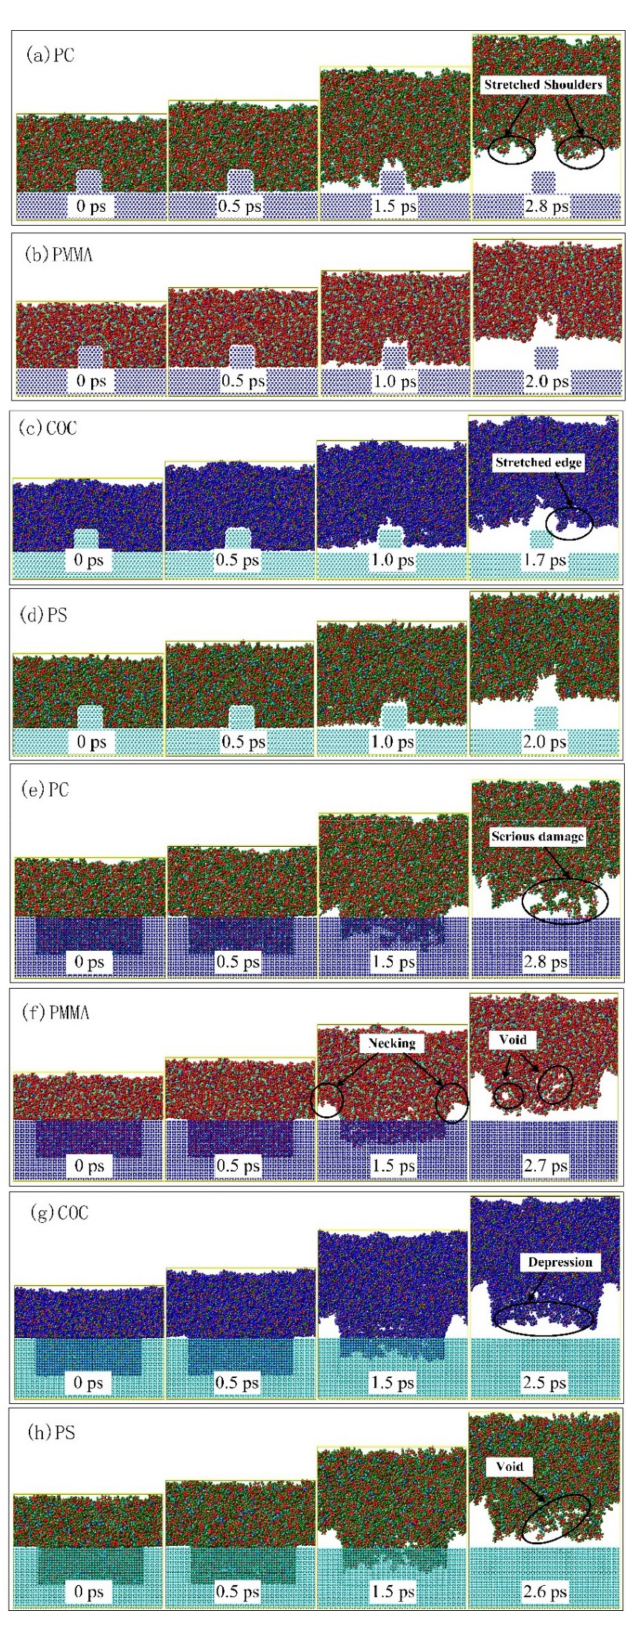
Figure 8. Snapshots of the channels and mixing structures of four polymers: ( a , e ) PC, ( b , f ) PMMA, ( c , g ) COC, ( d , h )